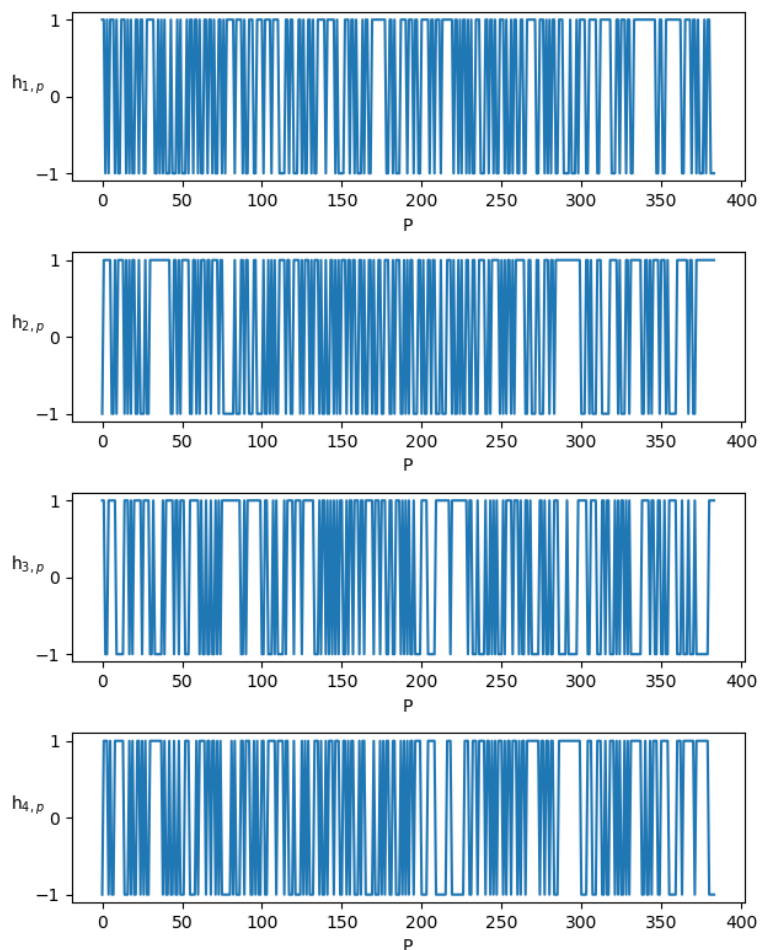
Figure 11. The multi- objective method fits the output unit’s fluctuations during training.